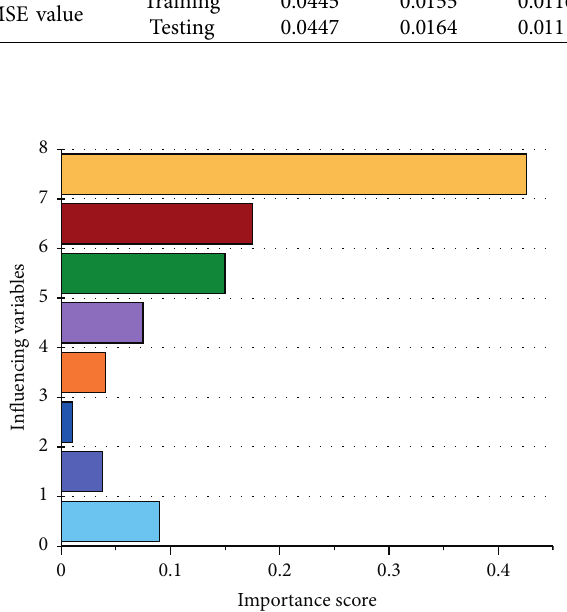
Figure 8: Relative importance of various influencing variables: (1: span; 2: width; 3: thickness; 4: length of the initial crack; 5: water/ cement ratio; 6: aggregate size distribution; 7: maximum aggregate size; 8: compressive